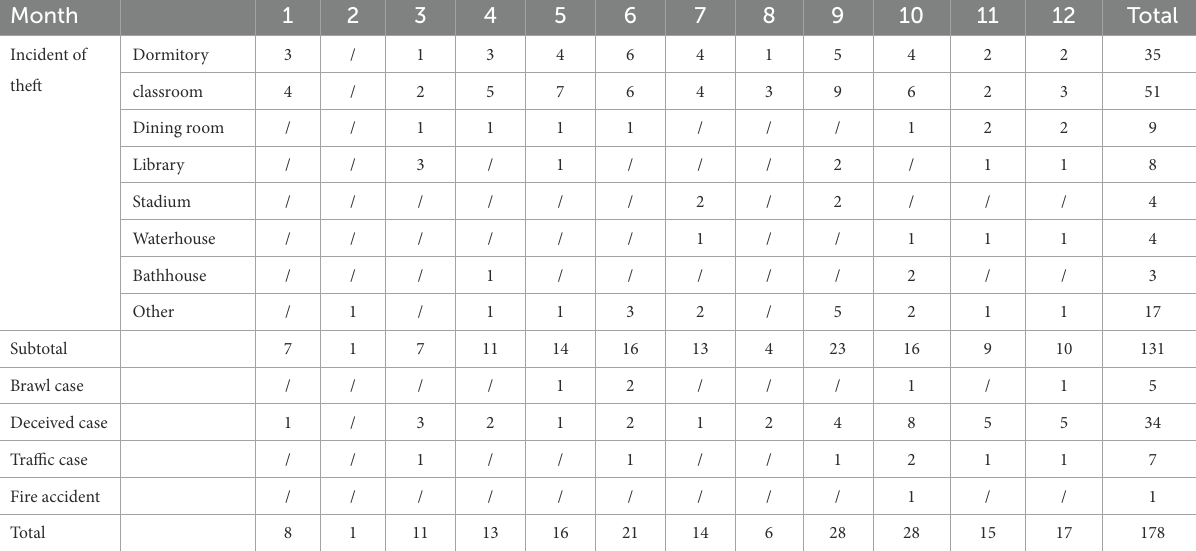
TABLE 3 Statistics on the occurrence of security incidents in a university in 2018. Month